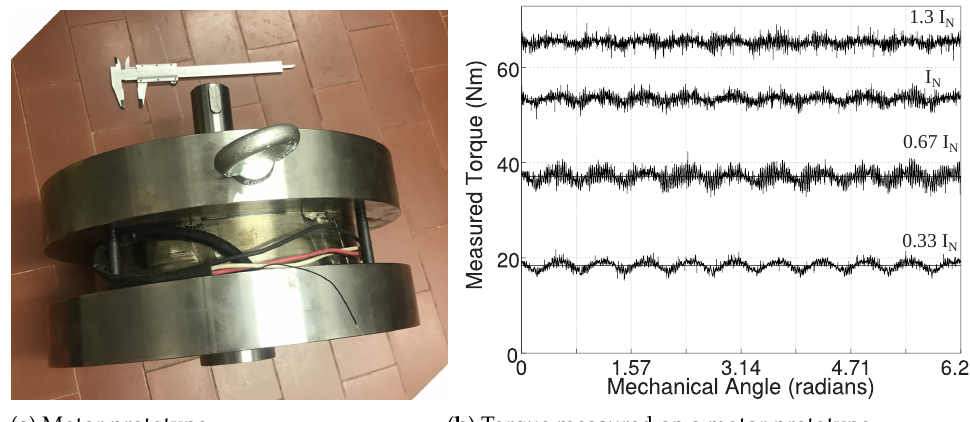
Figure 18. Experimental